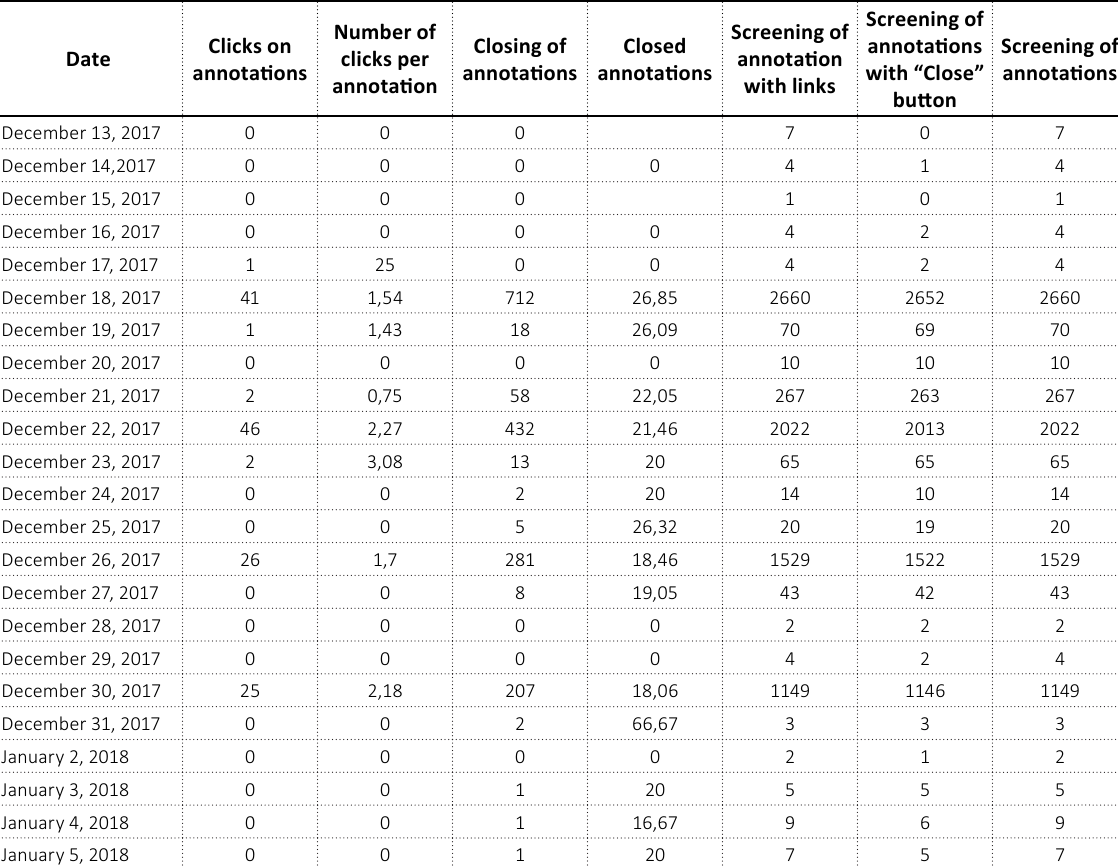
Table 3. Statistics of annotations in video clip screening for the period of 21 days of